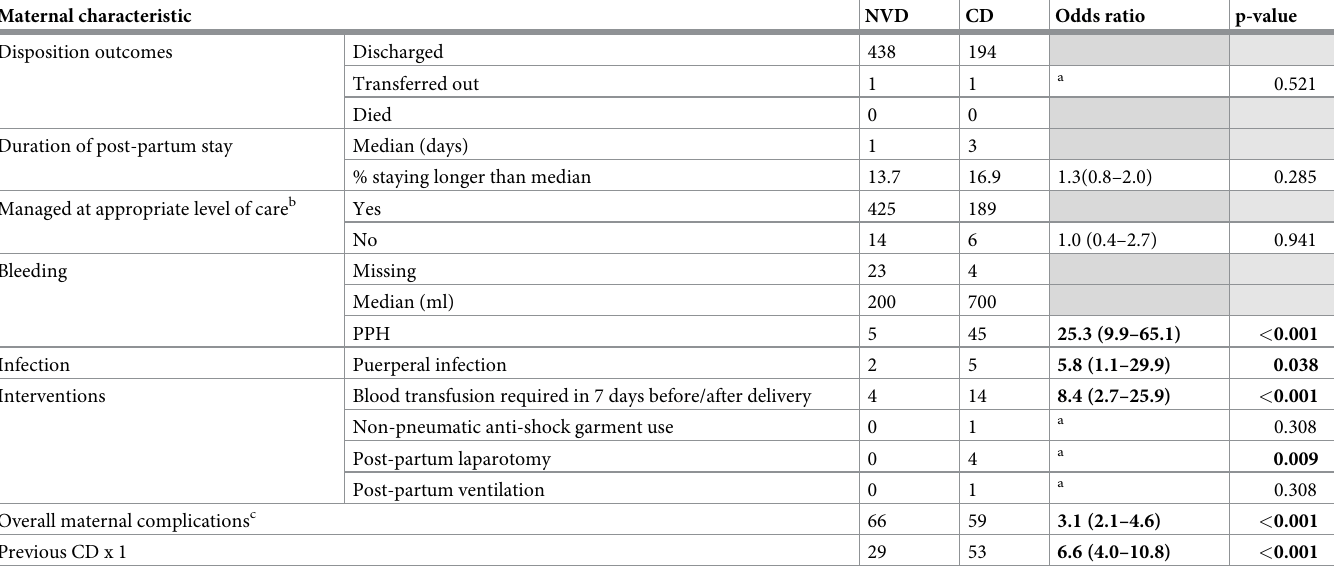
Table 5. Maternal